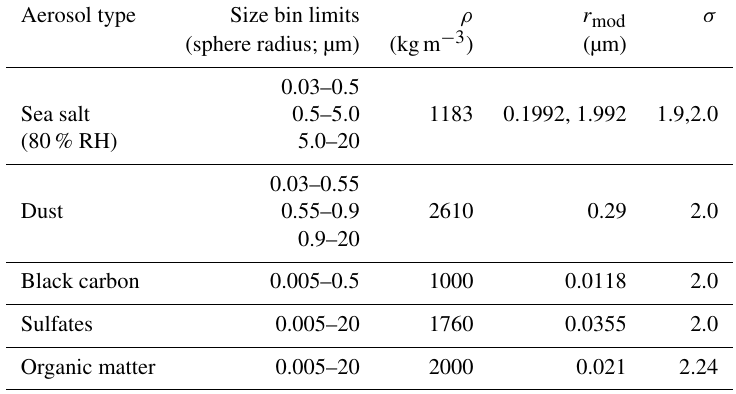
Table 1. Aerosol species and parameters of the size distribution associated with each aerosol type in IFS-AER ( r mod : mode radius, ρ : particle density, σ : geometric standard deviation). Values are for the dry aerosol apart from sea salt, which is given at 80% relative humidity (RH).